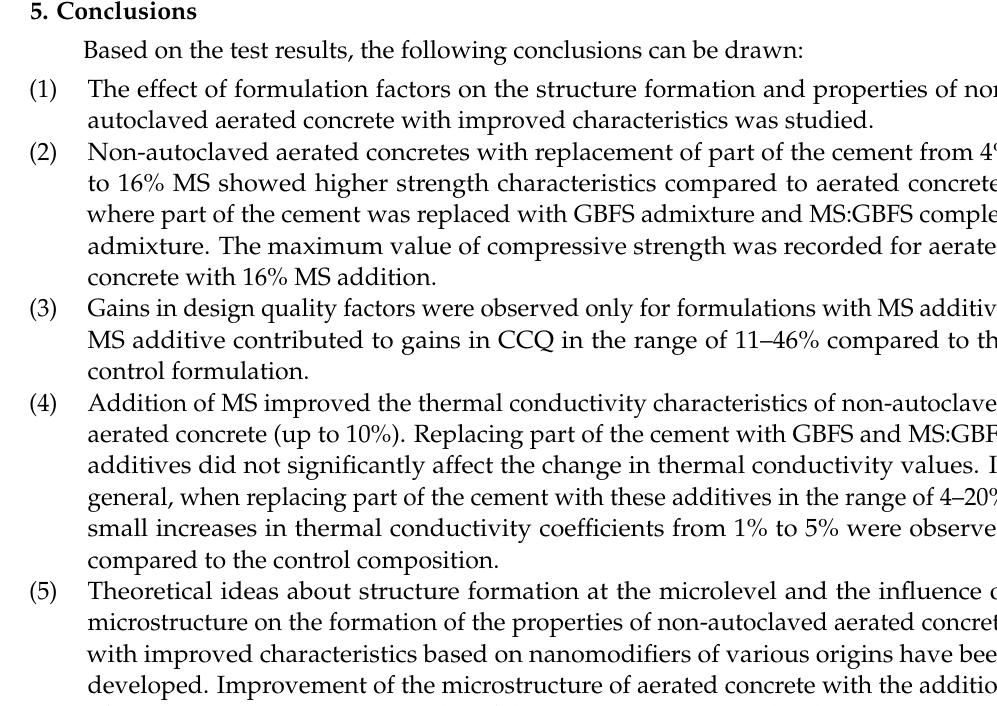
Figure 10. Factors affecting the properties of aerated concrete: (1–3)—the main groups of factors.